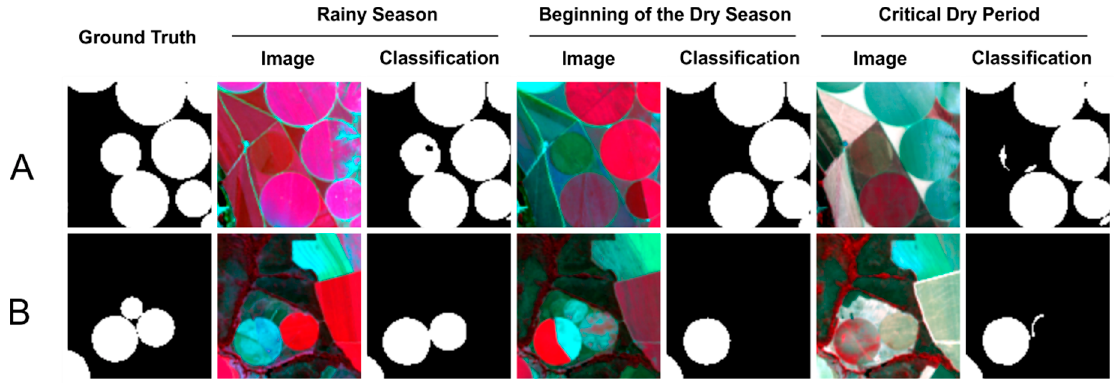
. Figure 13. Comparison of zoomed areas at di ff erent times of the year (rainy, early dry, and critical dry seasons). ( A ) Only the classified image from the rainy season detects the center pivots. ( B ) The image contains three pivots where the rainy season classification detects two, while the others detect only